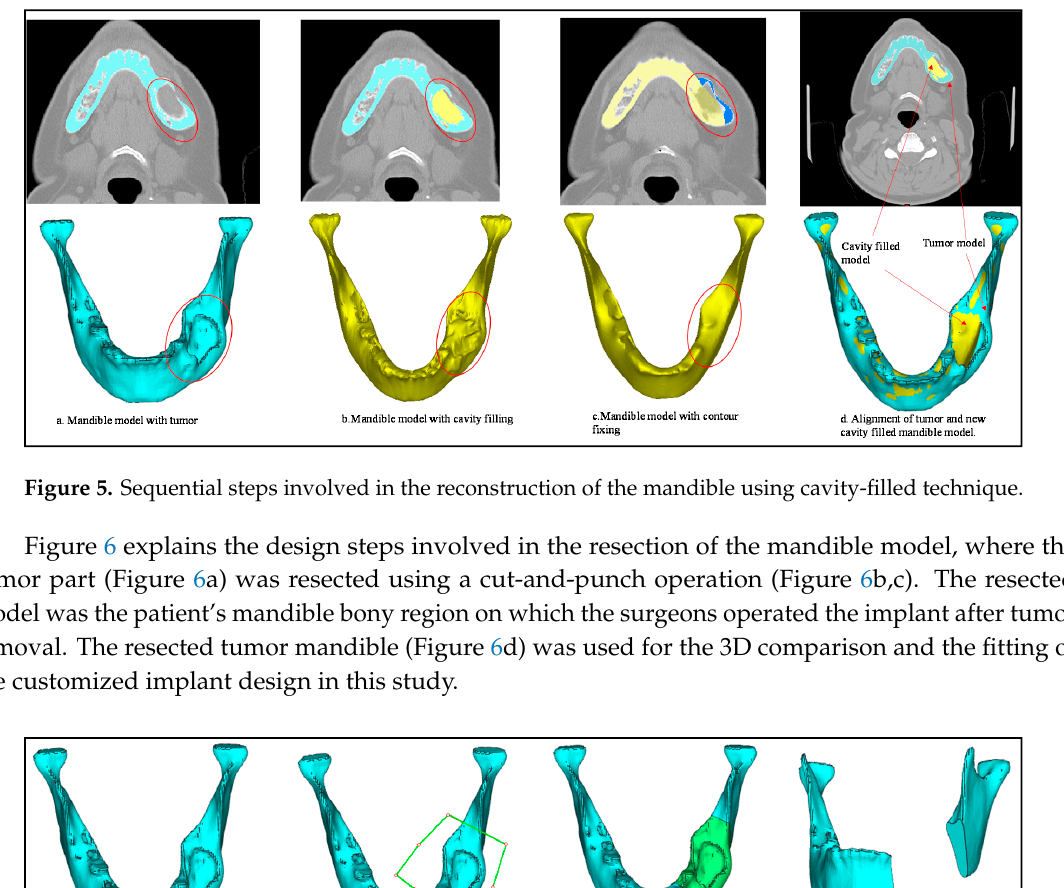
Figure 4. Steps involved in the three-dimensional reconstruction of the clean, healthy mandible using the mirroring technique.